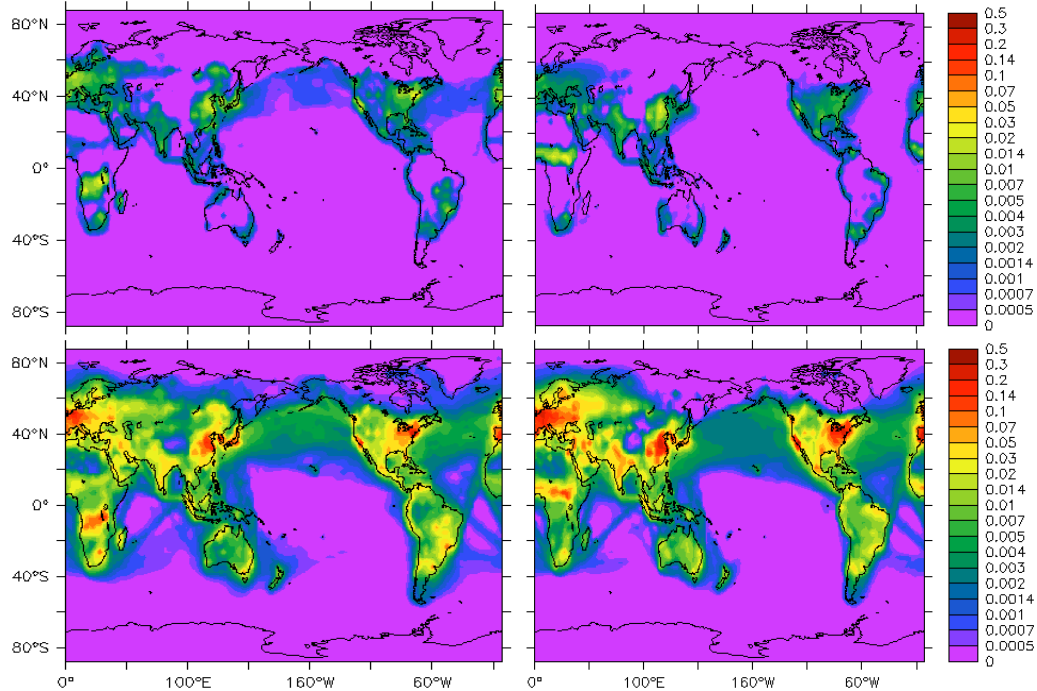
Figure 11: Simulated monthly average HONO mixing ratio near the surface in ppbv for the base (upper panel) and S2 (lower panel) scenarios in June (left) and December (right).